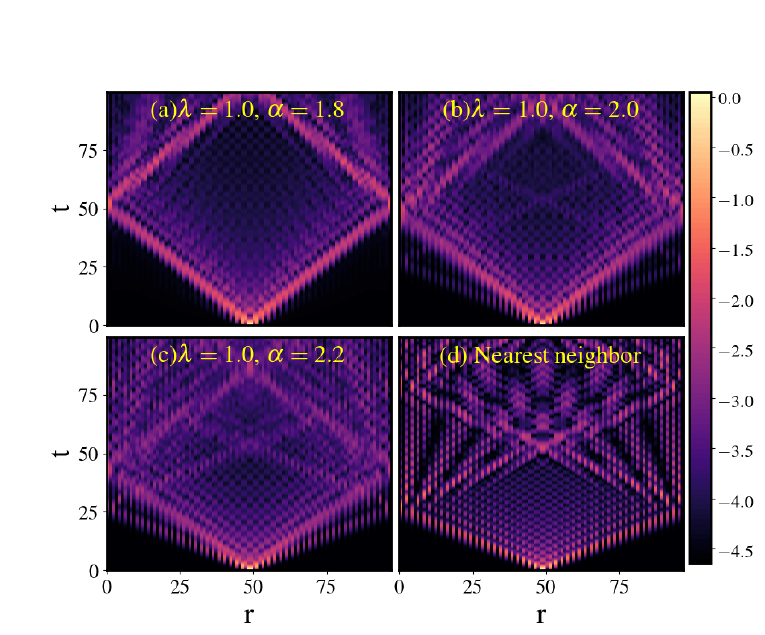
Figure 8: Spinon density 〈 N ↑ ( r , t ) N ↑ ( r + 1, t ) 〉 for λ = 1 and different values of α , obtained using Villain’s two-spinon approximation. Results for the nearest neighbor case are also included. Color density is in a log scale.